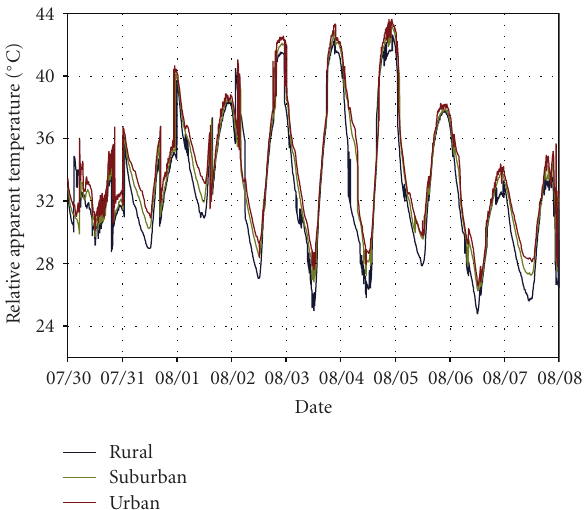
Figure 6: Composite urban (red), suburban (gold), and rural (blue) values of relative apparent temperature (KV86) from 30 July 2008 to 8 August 2008.